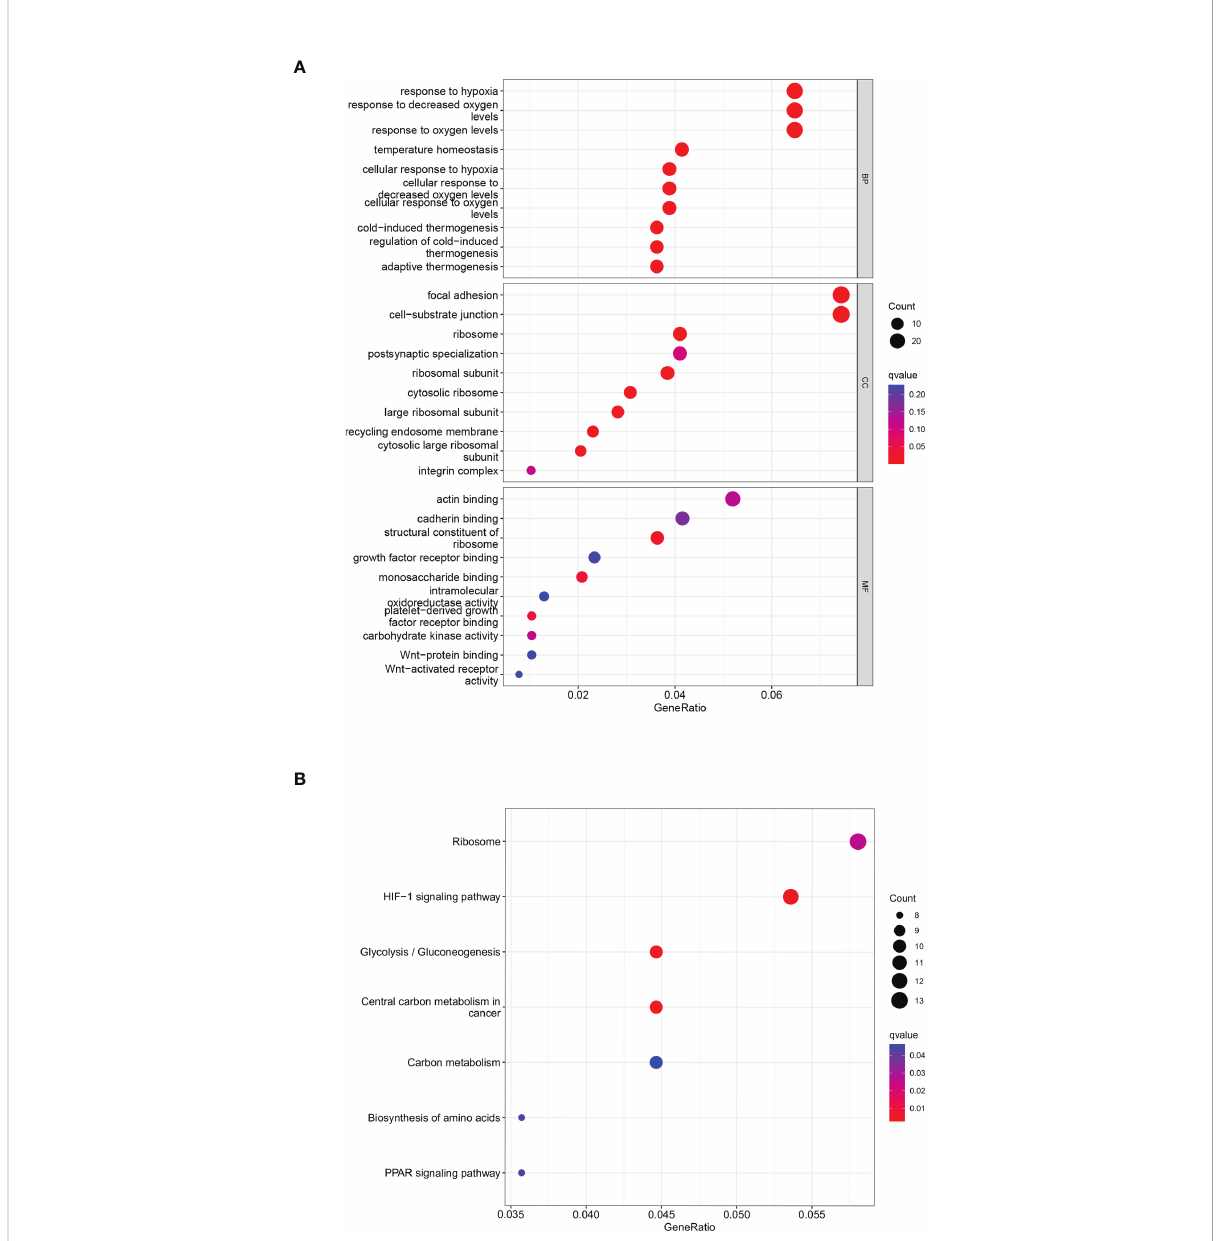
FIGURE 3 Functional enrichment analysis of genes in the screened modules. (A) The results of GO functional enrichment in GCSRGs. (B) The results of KEGG pathways enrichment in